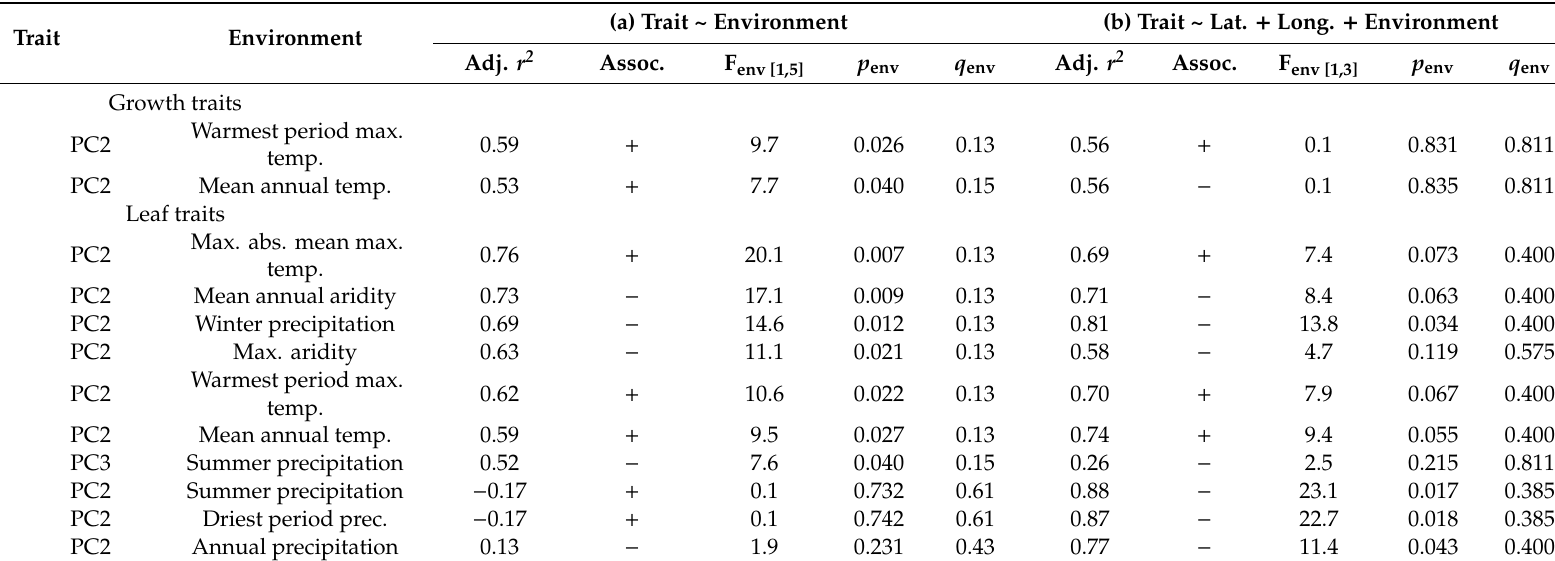
Table 4. Top climate associations ( p env < 0.05) for leaf and growth trait principal component (PC) axes in Eucalyptus microcarpa (Grey box), calculated (a) without and (b) with adjustment for spatial population structure (latitude and longitude). Note p env = significance of environmental component in the linear model; q env = accounts for multiple